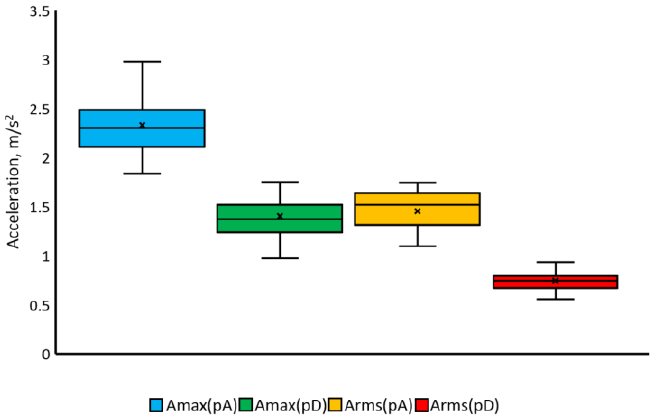
Figure 19. Summary of the values of maximum acceleration and RMS acceleration obtained during tests of precise hand movement.